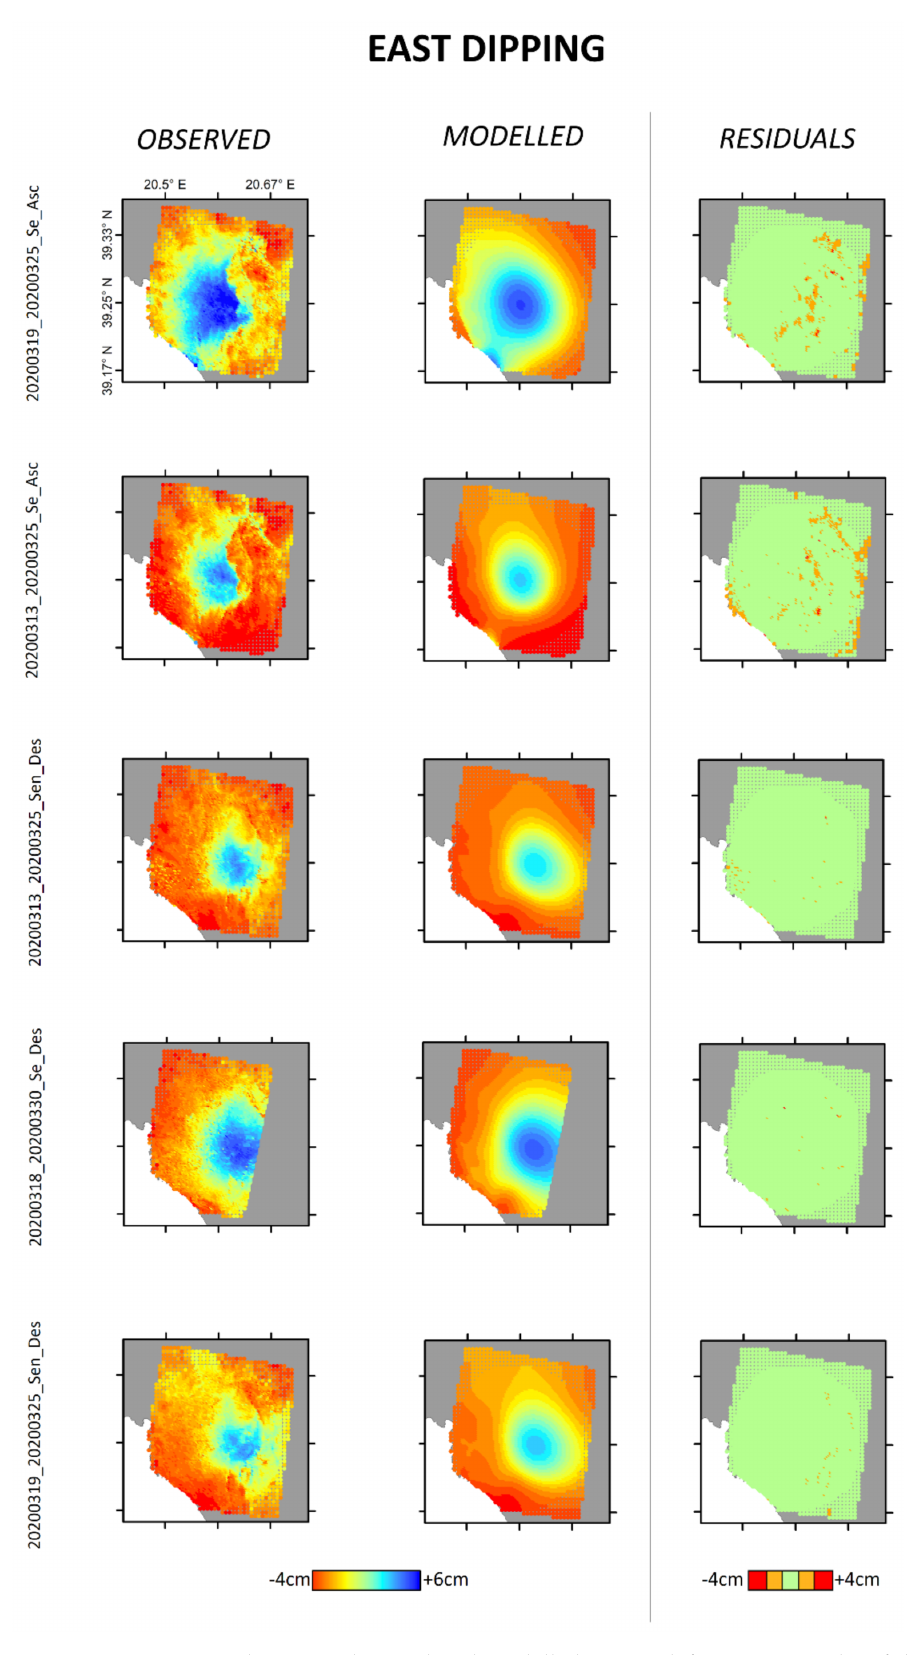
Figure 7. Comparison between observed and modelled InSAR deformation results of the linear inversion, for an east-dipping